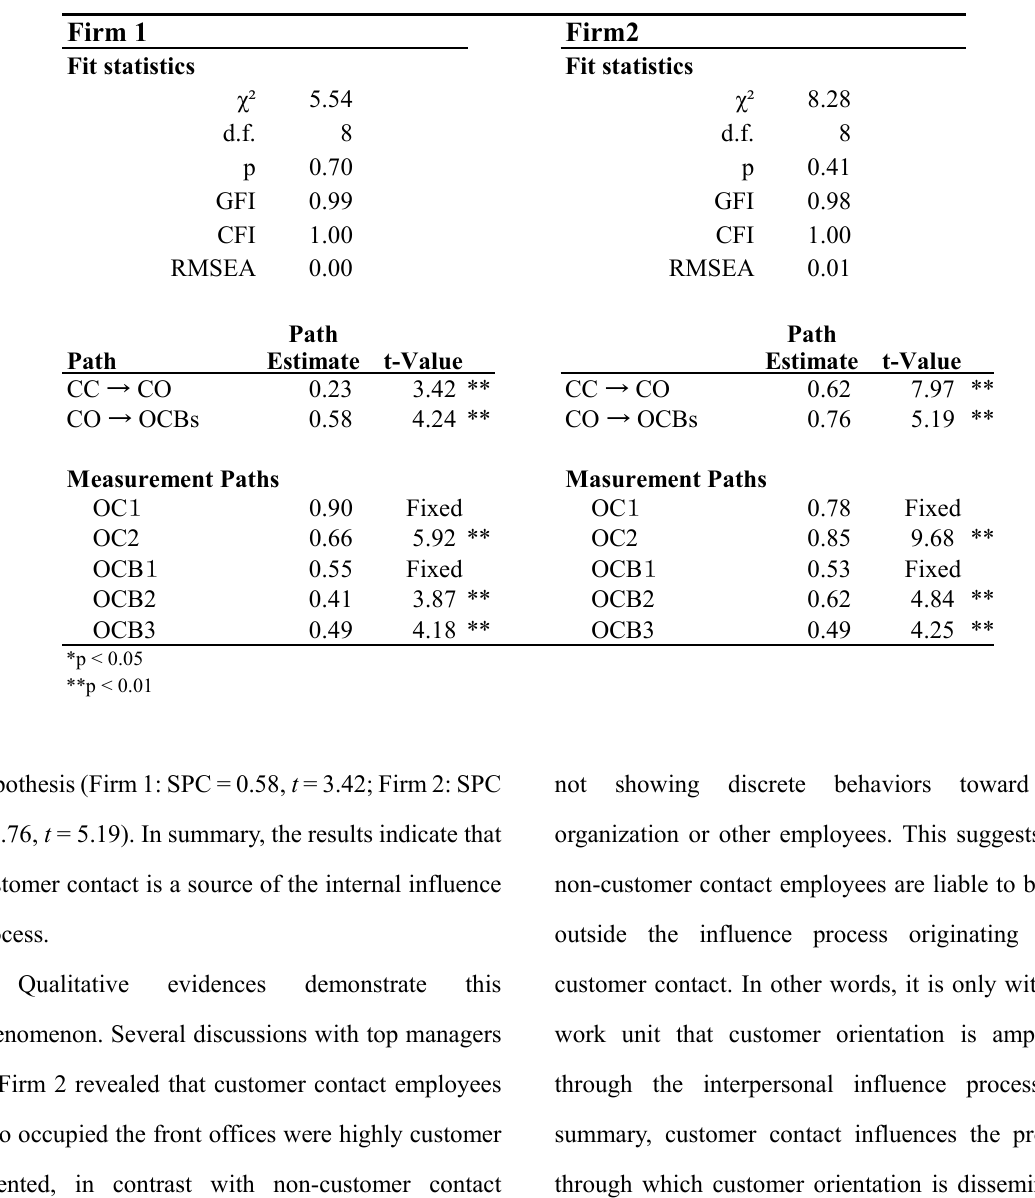
Table 2. Results of structural equation